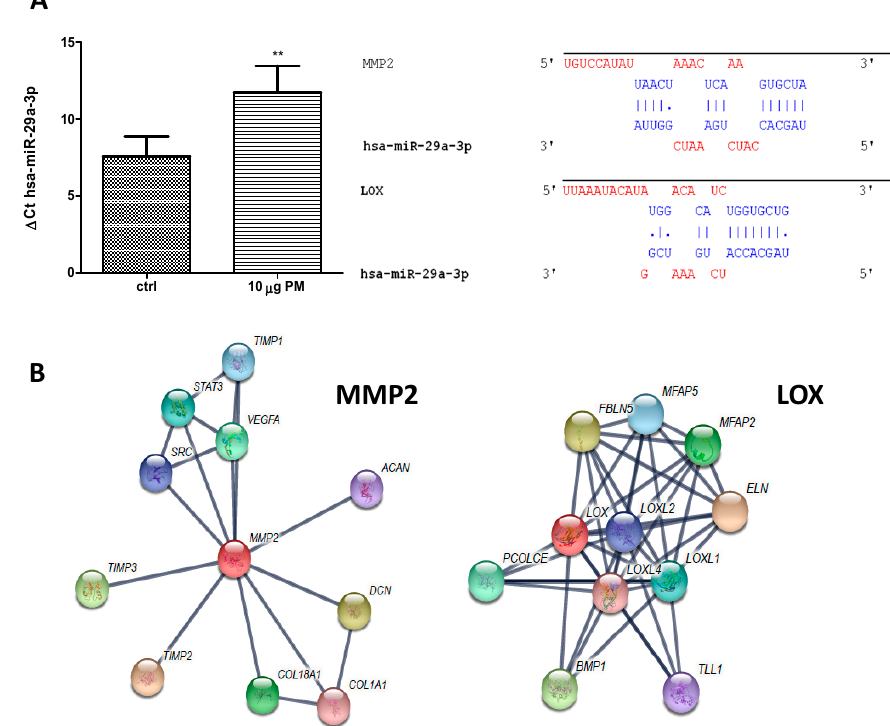
Figure 4. PM induce hsa-miR29-3p expression ( A ) has-miR-29a-3p expression without and with PM and its mRNAs interaction. ( B ) String data protein MMP2 and LOX interactions.